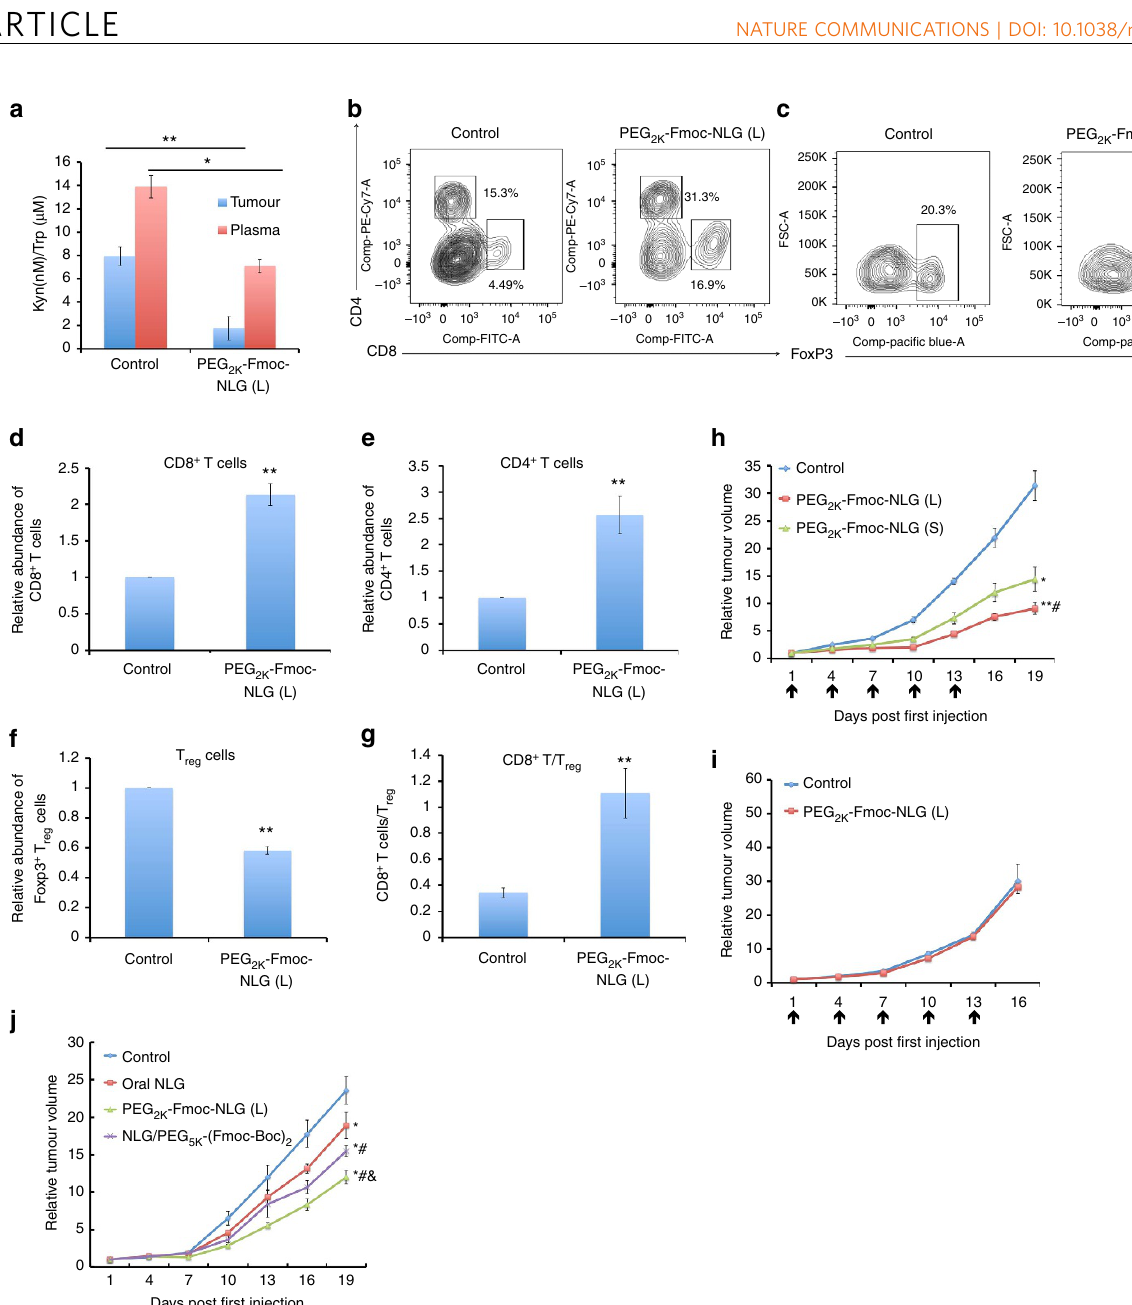
Figure 2 | In vivo biological activities of PEG 2k -Fmoc-NLG. ( a ) PEG 2k -Fmoc-NLG(L) treatment decreased kynurenine concentrations in plasma and tumours. BALB/c mice bearing s.c. 4T1.2 tumours of B 50mm 3 received PBS or PEG 2k -Fmoc-NLG(L) i.v. once every 3 days for 5 times at a dose of 25mg NLG919 per kg. Kynurenine/tryptophan ratios in plasma and tumours were determined by HPLC–MS one day following the last injection. Data are means ± s.e.m. of 3 experiments. * P o 0.05, ** P o 0.01. ( b – g ) IDO1 inhibition by PEG 2k -Fmoc-NLG(L) increased CD4 þ and CD8 þ Tcells, and decreased T reg cells in tumours. Tumour-bearing mice were treated as described above. ( b ) Gating of CD8 þ and CD4 þ Tcells (marked with black boxes) as a percentage of CD45 þ lymphocytes. ( c ) Gating of T reg (CD4 þ FoxP3 þ ) cells (marked with black boxes) as a percentage of CD4 þ lymphocytes. ( d , e ) Relative number of intratumoural CD8 þ ( d ) and CD4 þ ( e ) T cells following different treatments. ( f , g ) Relative number of T reg cells ( f ) and CD8 þ T cells/T reg ( g ) in tumour tissues. Data represent means ± s.e.m. (** P o 0.01, N ¼ 5). ( h ) PEG 2k -Fmoc-NLG maintained the tumour inhibitory effect. Mice bearing tumours of B 50mm 3 received different treatments as indicated (black arrows). * P o 0.05; ** P o 0.01 (versus control, N ¼ 5), # P o 0.05 (versus PEG 2k -Fmoc-NLG(S), N ¼